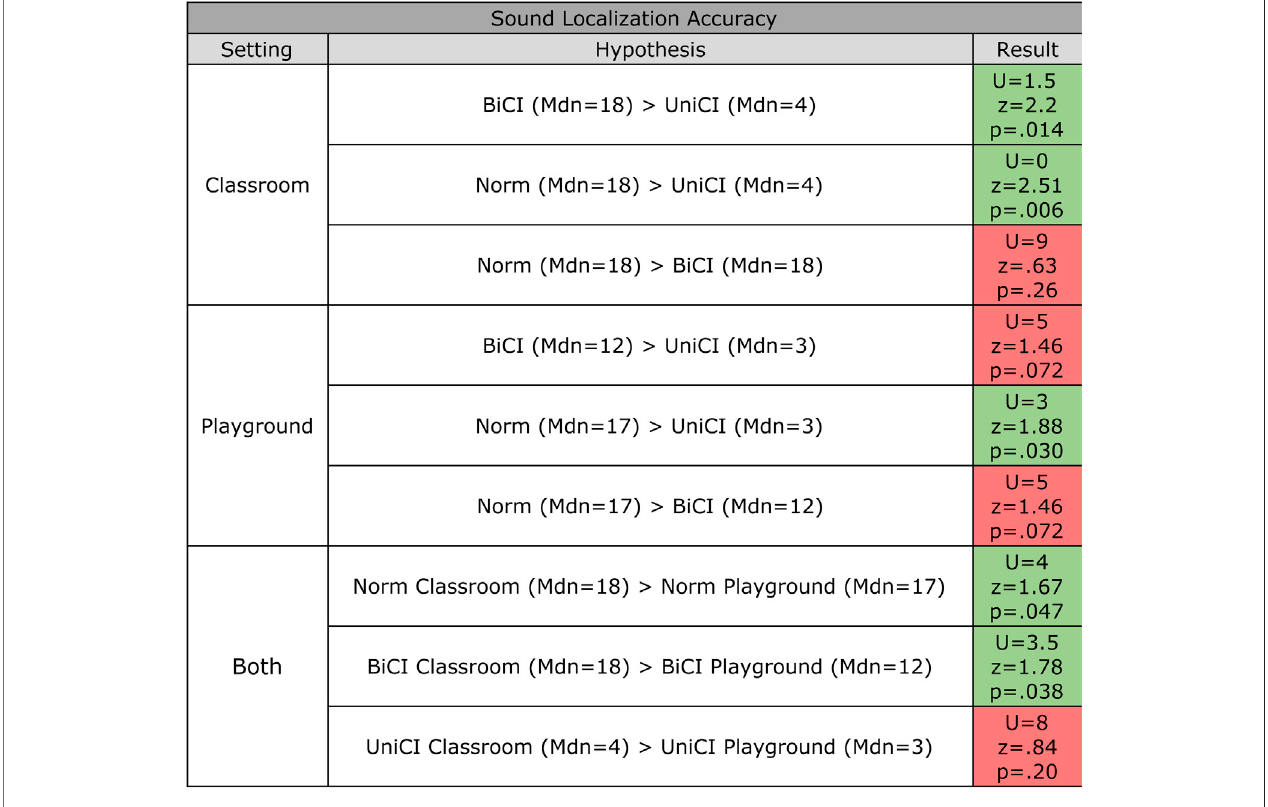
Frontiers in Virtual Reality |